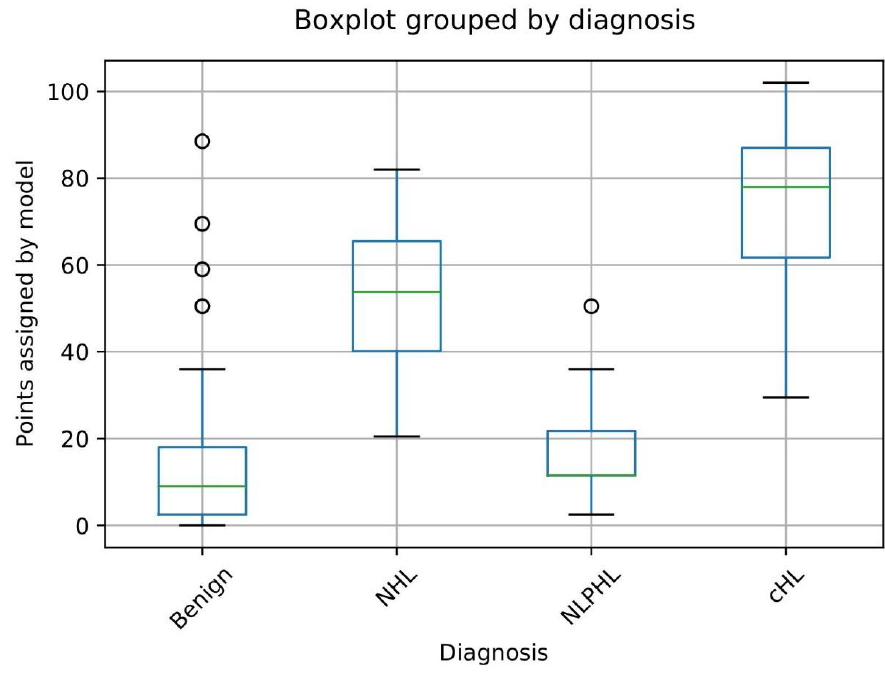
Figure 3. Overview of scored points according to our diagnostic model distributed in four outcome groups. The diagnostic model could discriminate excellently ( p < 0.001) between the benign group (median 9.0, 25 – 75 percentiles 2.5 – 18.0 points) and the cHL group (median 78.0, 25 – 75 percentiles 62.0 – 87.0 points) and between the benign group and NHL group (median 54.0, 25 – 75 percentiles 40.0 – 65.5). The model could not discriminate between NLPHL and the benign group. Abbreviations: NHL—non-Hodgkin lymphoma; NLPHL—nodular lymphocyte-predominant Hodgkin lymphoma; cHL—classical Hodgkin lymphoma. A